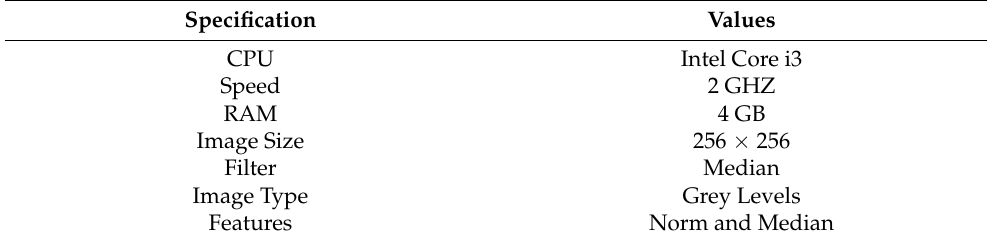
Table 1. The filter used in experiments by default is Median, and in tests, we usually used Norm and Median for extracting features from images. Table 1. Experimental